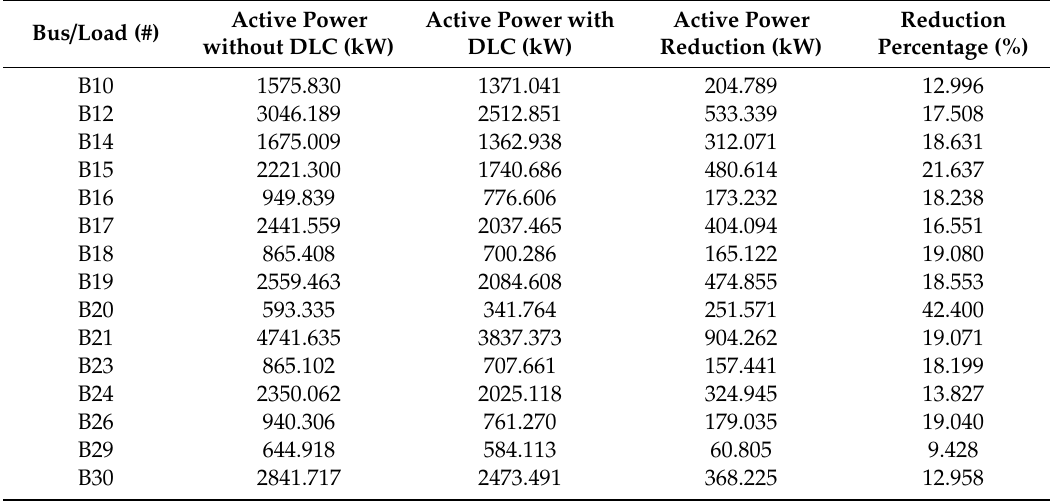
Table 7. Case VI: Active power with / without DLC in the presence of